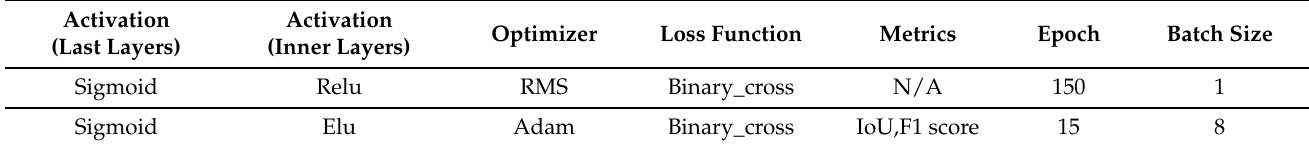
Table 1. Summary of the FCN and U-net model parameters for the training process. Activation (Last Layers)